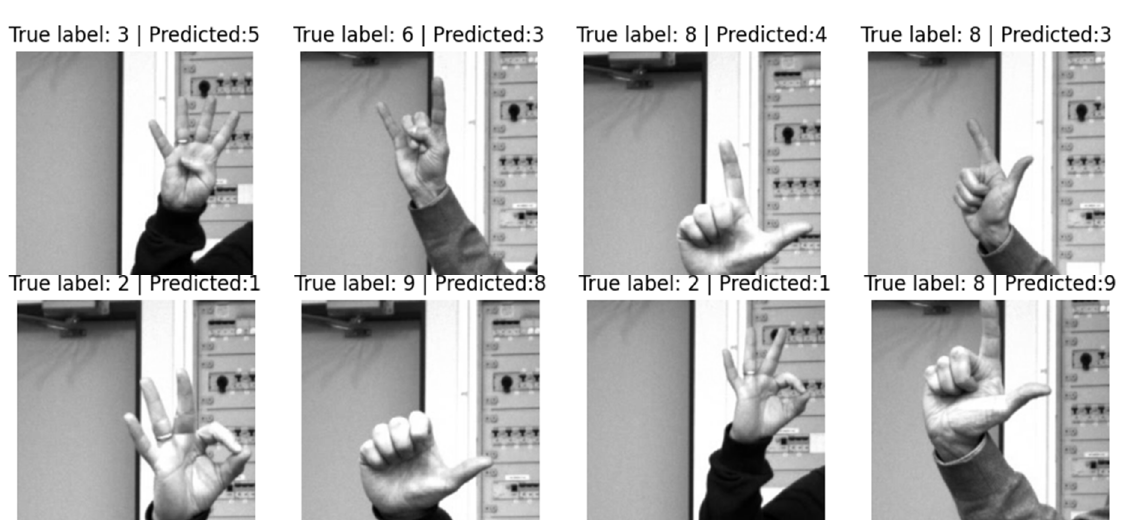
Figure 18. Confusion matrixes for test set of grayscale ( a ) and RGB ( b ) images for ResNet50. Table 3. 2D CNN classi fi ers comparison.